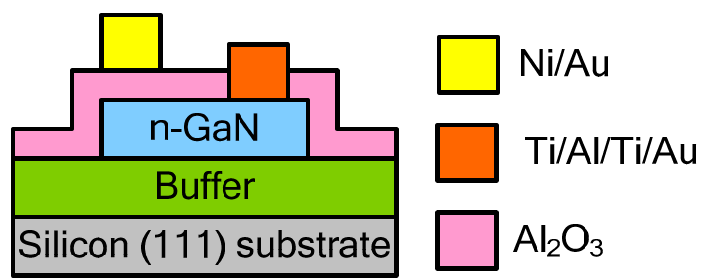
Figure 1. Schematic of an MOS capacitor.